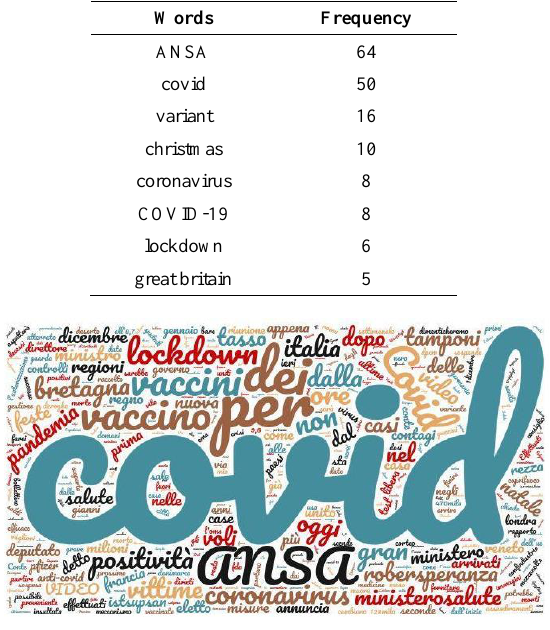
Table 10. Frequency of the most common words for negative peaks